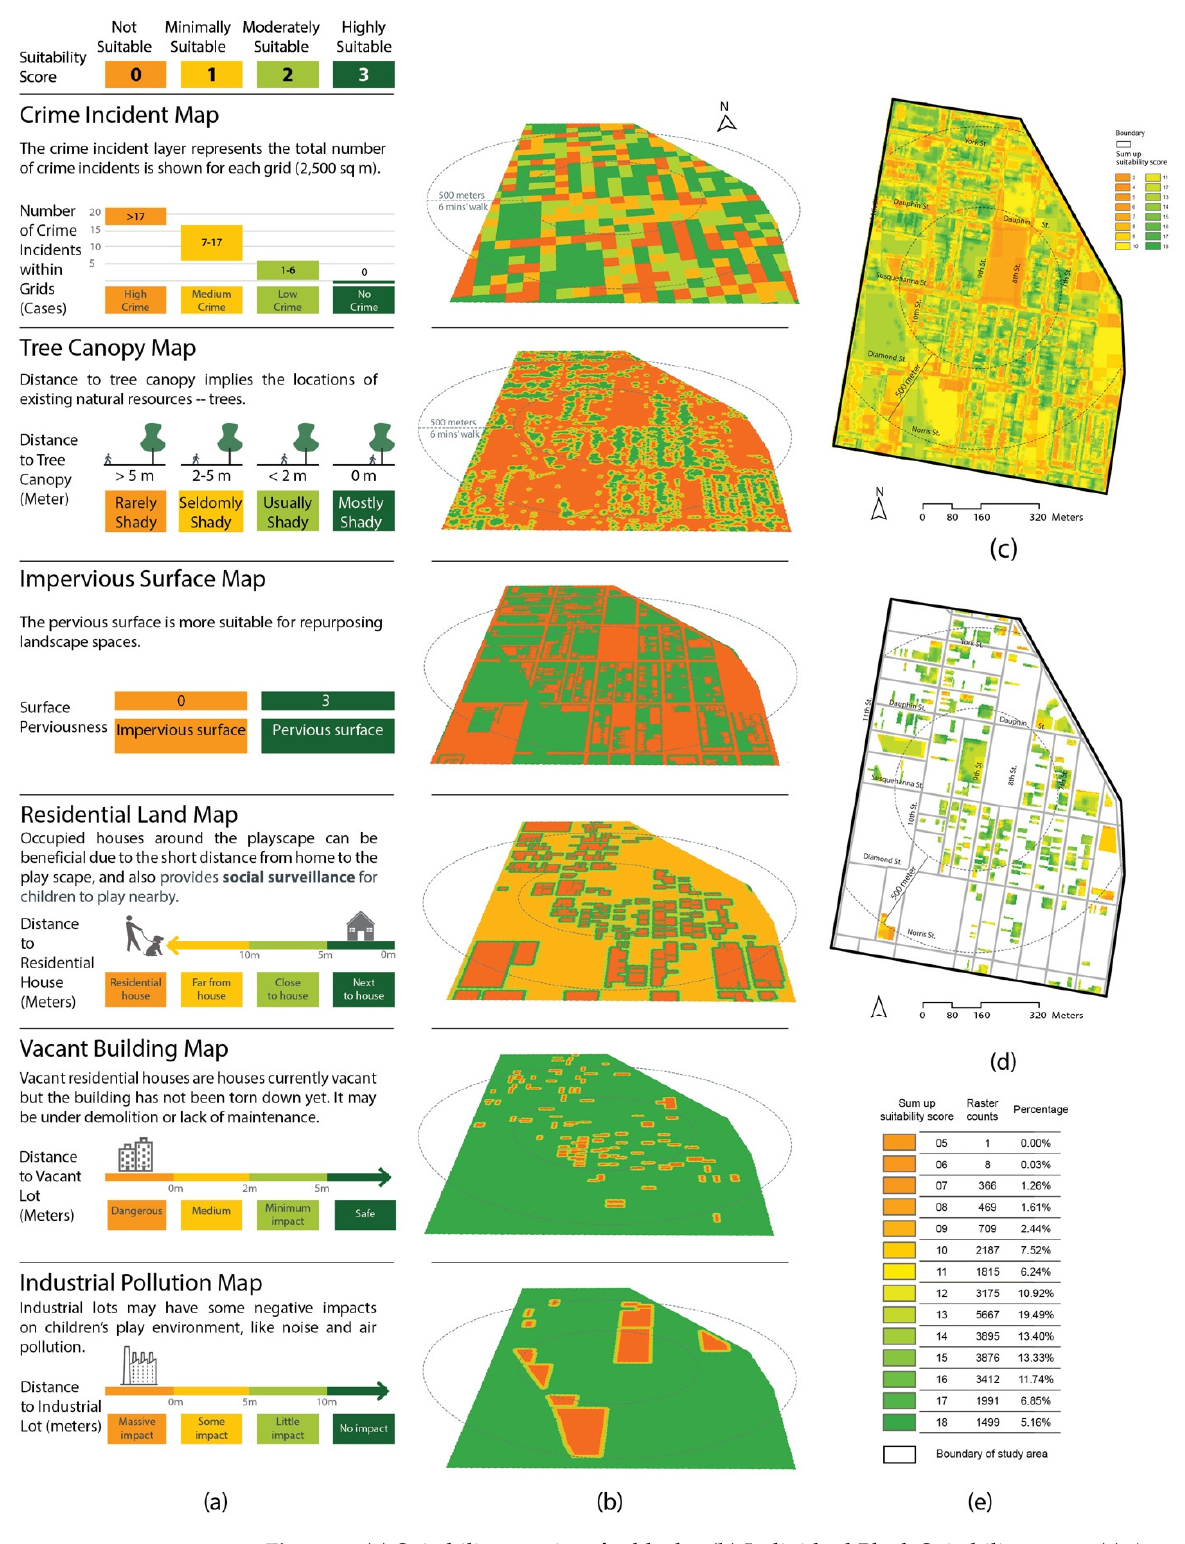
Figure 4. ( a ) Suitability matrices for blocks; ( b ) Individual Block Suitability maps; ( c ) Aggregated Block Suitability map; ( d ) Vacant Lot Aggregated Suitability map; ( e ) Vacant Lot Suitability Score summary